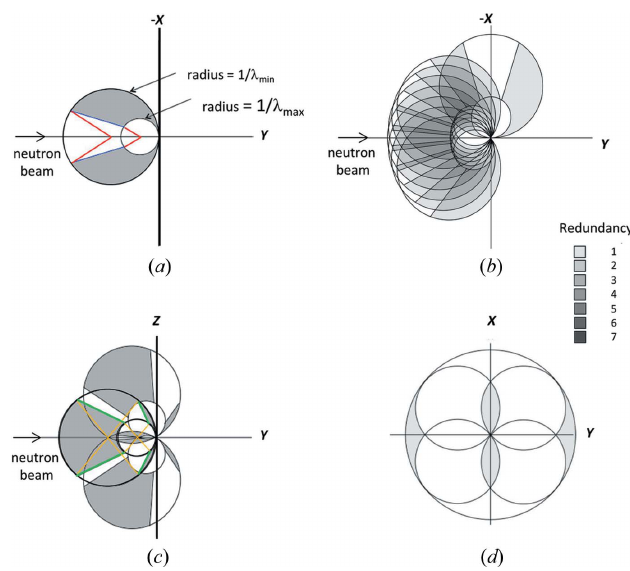
Figure 2 ( a ) Observable excited area in the equatorial plane for ’ = 0 (cid:6) , with x , y and z (pointing out of the page) being the instrumental orthogonal coordinates system. The accessible areas of reciprocal space are dark grey in all insets. ( b ) Ewald construction in Laue geometry in the equatorial plane for typical high-pressure data collections using the mini-DAC. ( c ) Ewald construction in Laue geometry in the vertical instrumental yz plane (with x pointing out of the page) given a reorientation by (cid:9) 120 (cid:6) , as possible with the mini-DAC. In this instance, the blind regions can be attributed to the erasing lamps, the incident- and transmitted-beam holes are ignored. Note that covered areas in ( b ) and ( c ) could be reflected through the origin, according to Friedel’s law. However the figures would be much more cluttered and therefore their reflections are omitted for the sake of clarity. ( d ) Ewald construction in monochromatic geometry in the equatorial plane for typical high-pressure data collections using a DAC with an opening half angle = 39 (cid:6) (cell axis is along y ), assuming that the cell body is shielded. Entry of the incident beam from both sides of the cell is